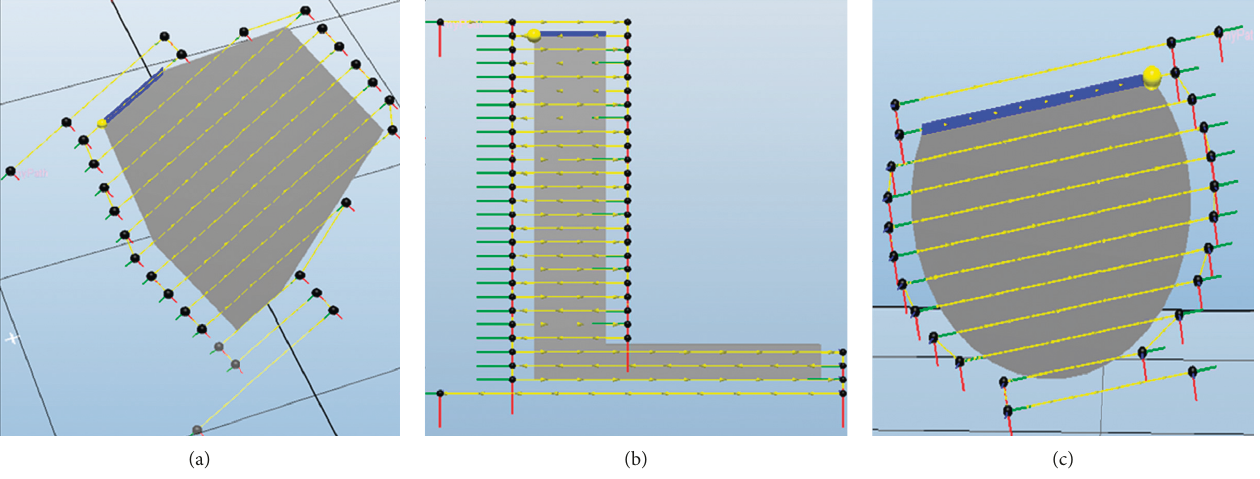
Figure 12: Autogenerated trajectory on a type of irregular straight-edge polygons.